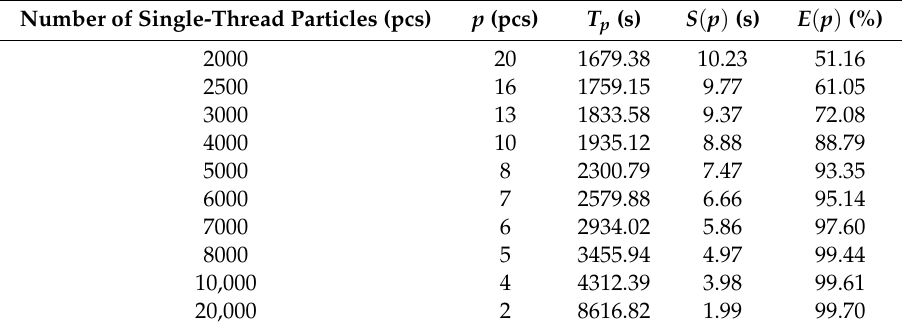
Table 5. Case 3 speed-up and parallel e ffi ciency under di ff erent